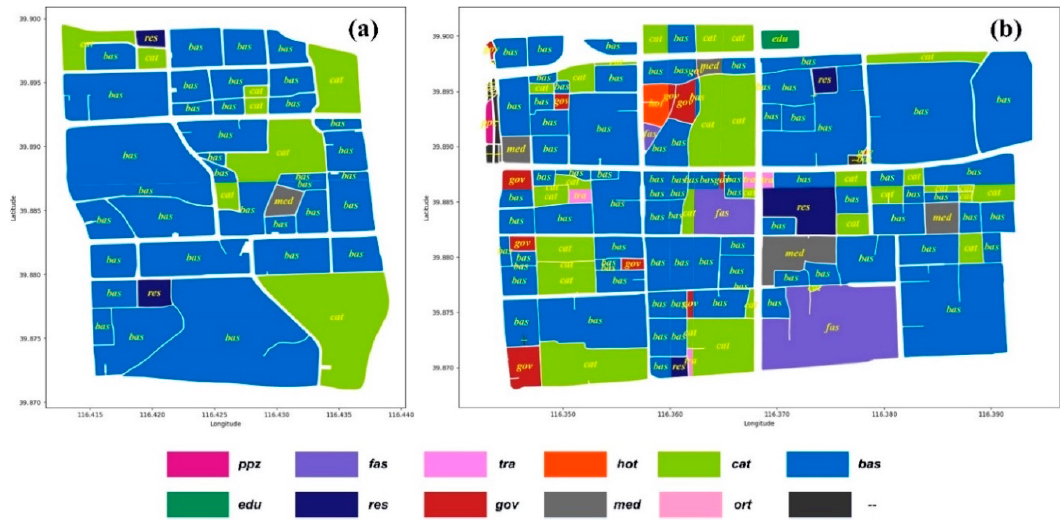
Figure 13. Illustration of dominant function within parcels: ( a ) dominant functions of Parcel 1 , and ( b ) dominant functions of Parcel 2 . In the legend, “–” represents that there is no POI in this parcel.